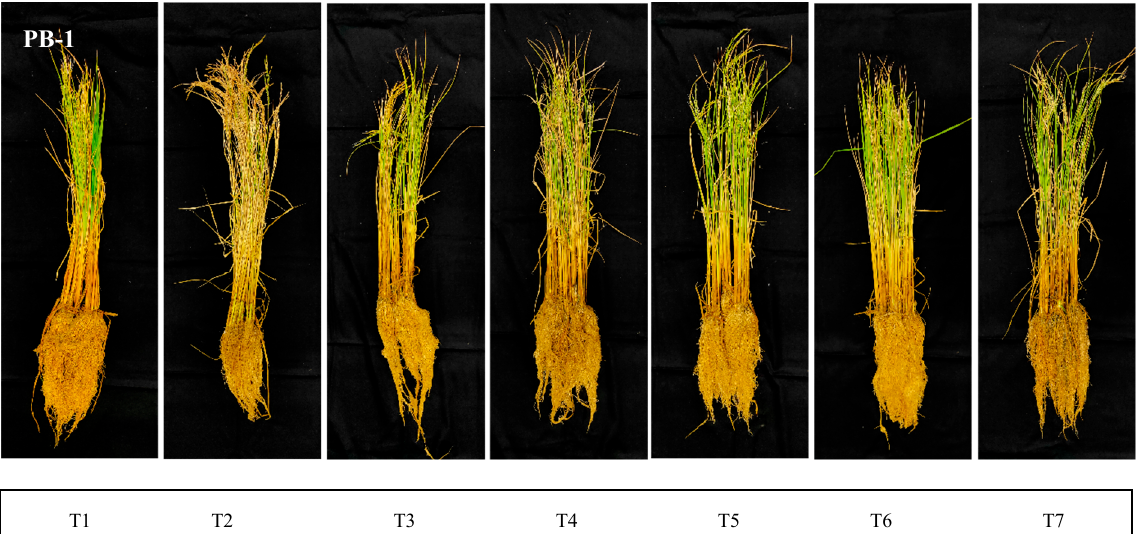
Figure 2. Effect of inoculation of halotolerant endophytes and rhizobacteria on root and shoot development in two rice varieties: CO51 and Pusa Basmati-1 (PB1). Sequence of pots from left to right: T1 = Negative control, T2 = Positive control (200 mM NaCl), T3 = 200 mM NaCl + Trichoderma viride , T4 = 200 mM NaCl + Bacillus haynesii 2P2, T5 = 200 mM NaCl + Bacillus safensis BTL5, T6 = 200 mM NaCl + Brevibacterium frigoritolerans W19, and T7 = 200 mM NaCl + Pseudomonas fluorescens.